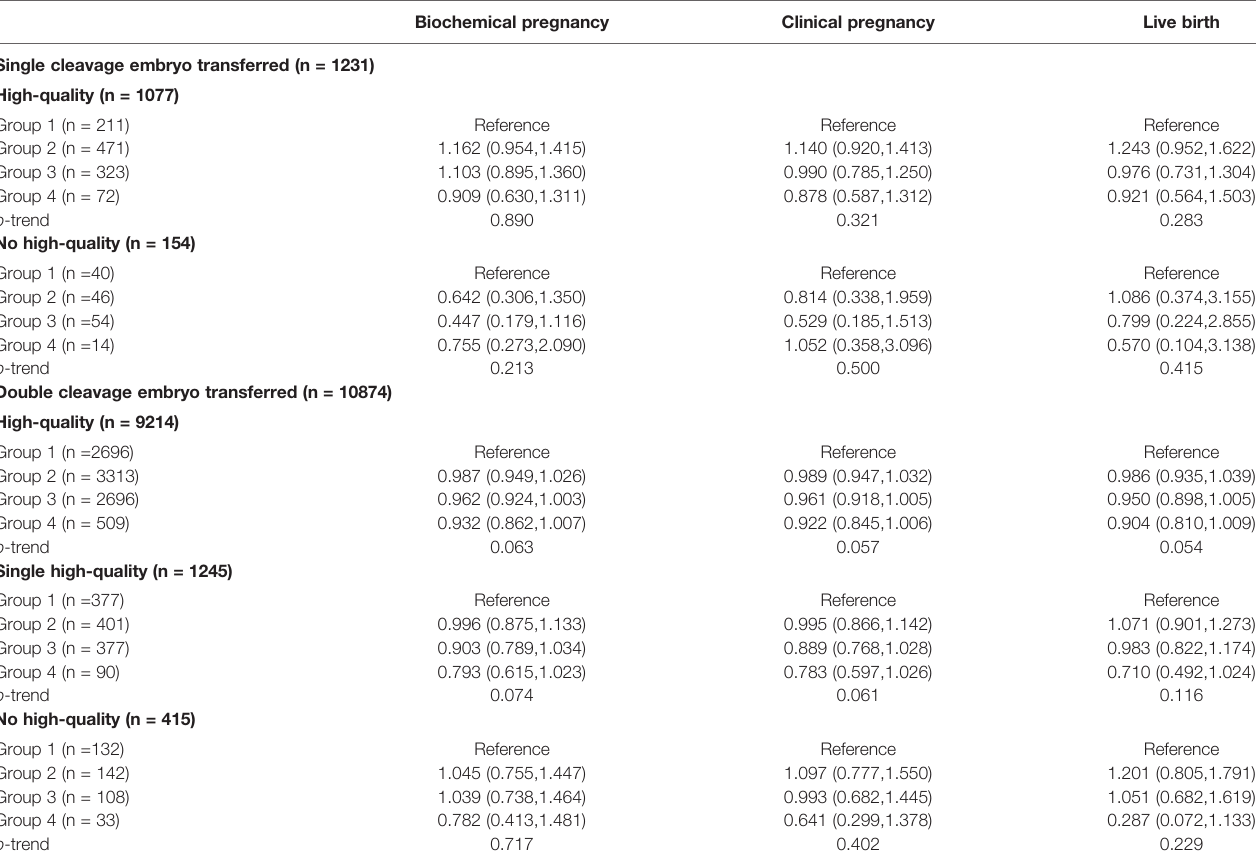
TABLE 3 | The results of strati fi cation analyses assessing the associations between cryopreservation time and pregnancy outcomes based on the number and quality of cleavage embryos transferred. Biochemical pregnancy Clinical